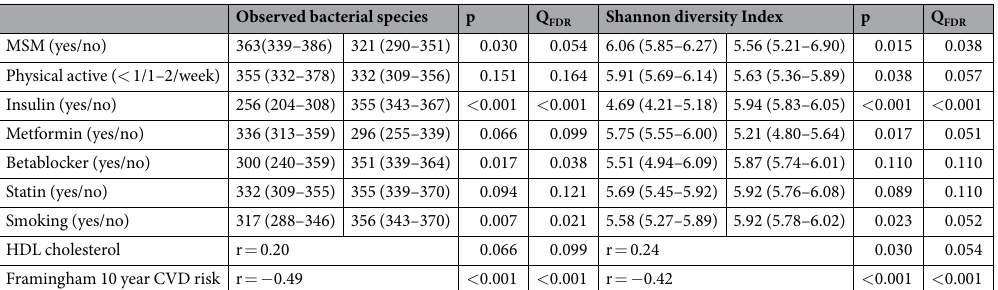
Table 2. Association between covariates and gut microbiota diversity. Covariates with p < 0.10 are given. Data as mean (95% CI). Smoking and HDL cholesterol are part of the Framingham 10 year CVD risk, and were not entered as separate covariates in the multivariate linear regression model. MSM: men who have sex with men. MSM status was only available in HIV infected individuals. MSM status “no” refers to heterosexual transmission, IDU and unknown